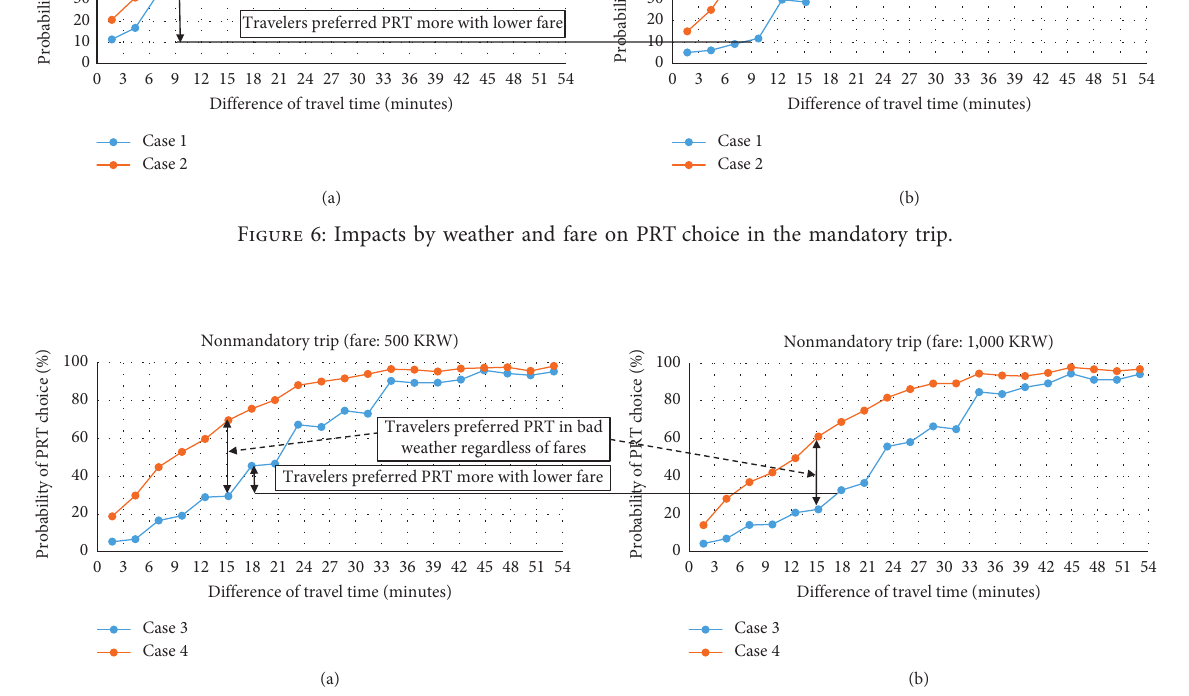
Figure 7: Impacts by weather and fare on PRT choice in the nonmandatory trip without company.